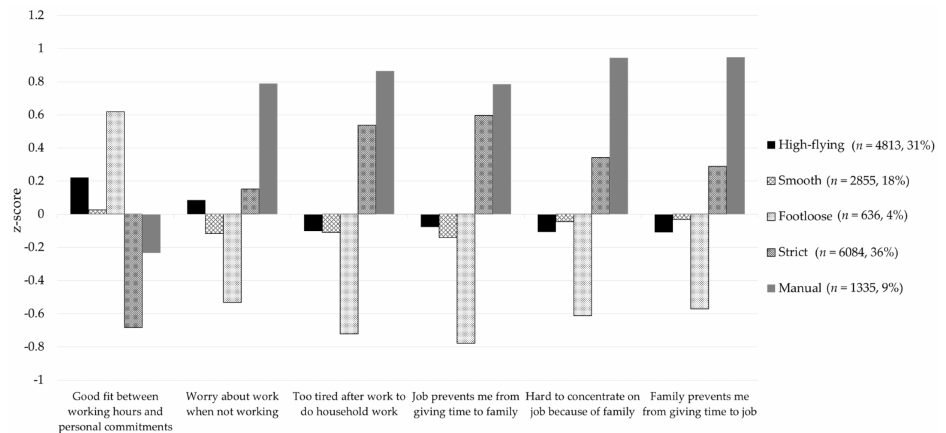
Figure 5. Associations between job quality profiles and work-life